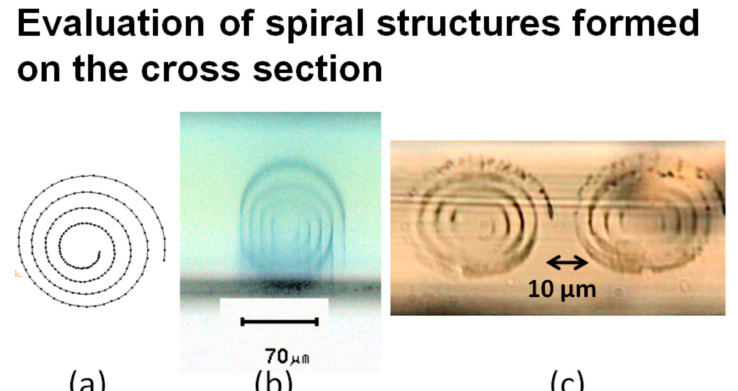
Figure 4. Relationships between the incident laser exposure and the line width of the PEDOT deposition ( a ), and relationships between the incident laser exposure and the aspect ratio ( b ).